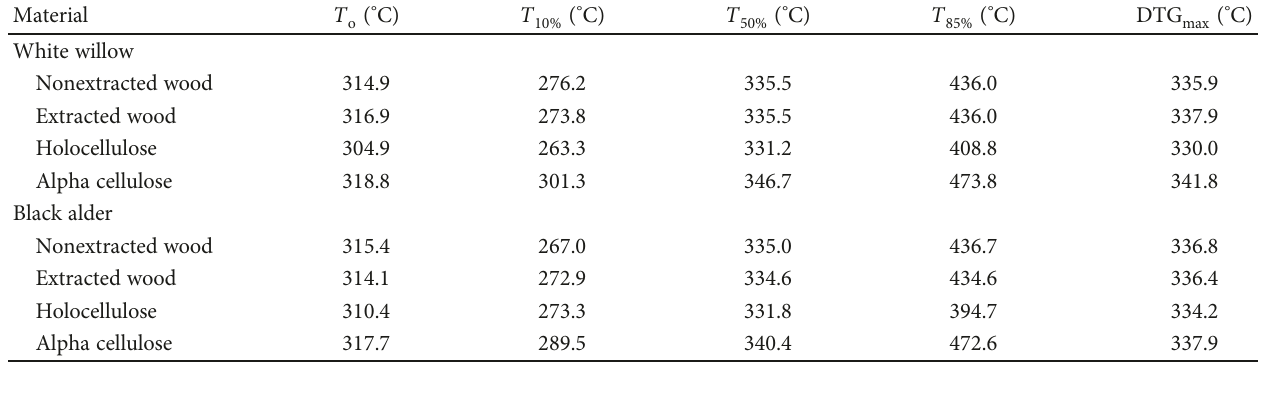
Table 2: Summary of TGA data on wood and di ff erent types of fi llers used.